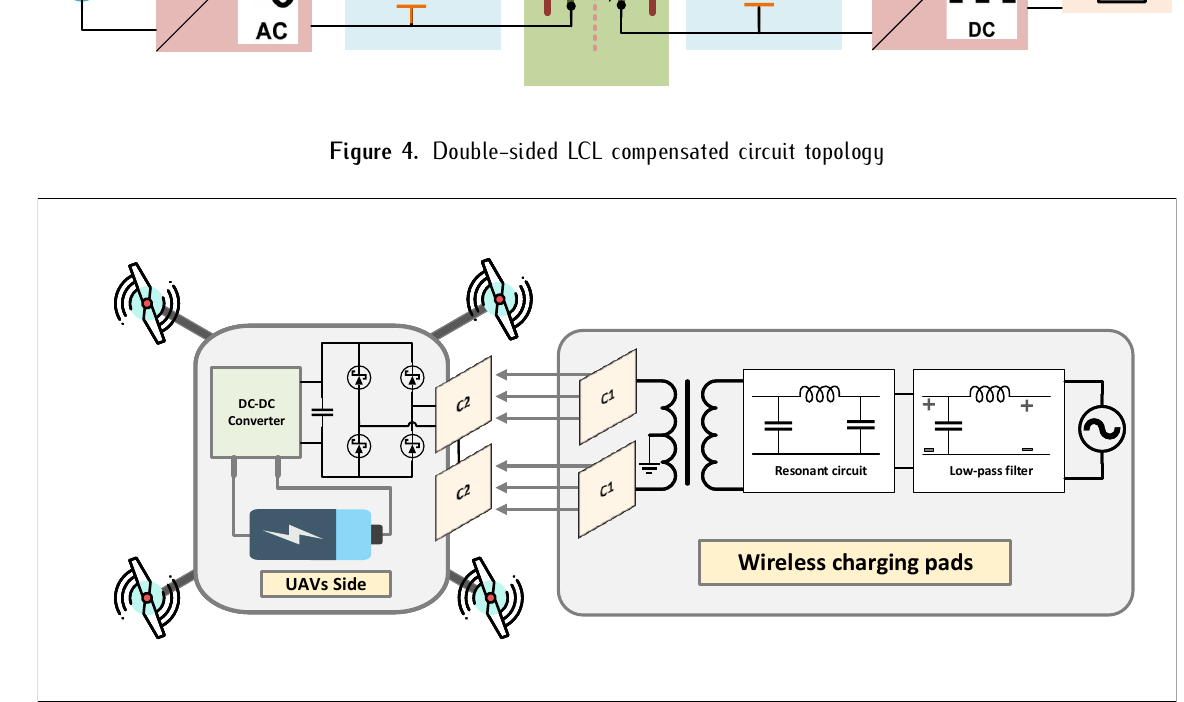
Figure 5. [69] CPT-wireless batteries charging for drone